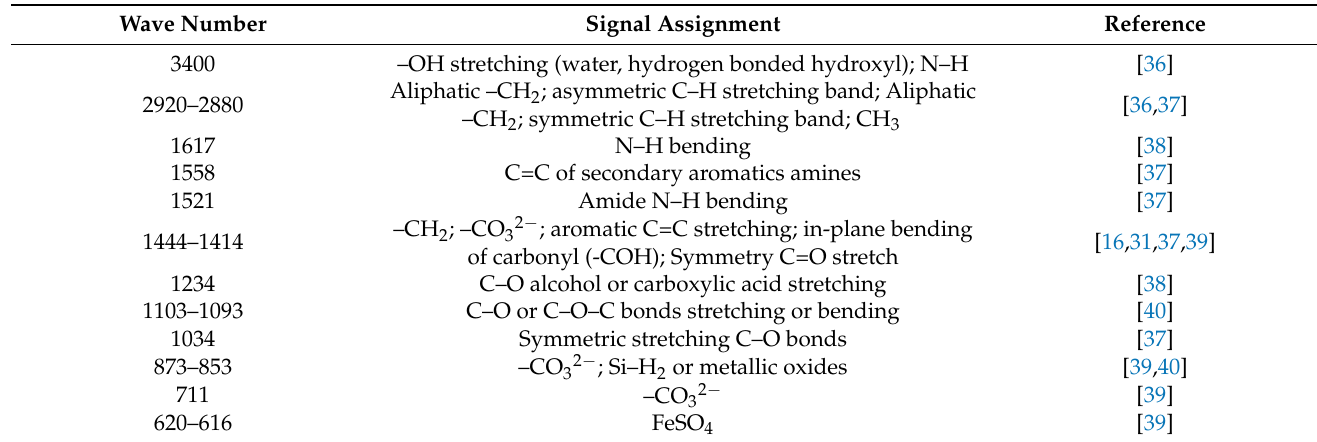
Table 3. Reflectance Fourier transform infrared (FTIR) spectrum signal assignments for study biochar samples BC300, BC450, and